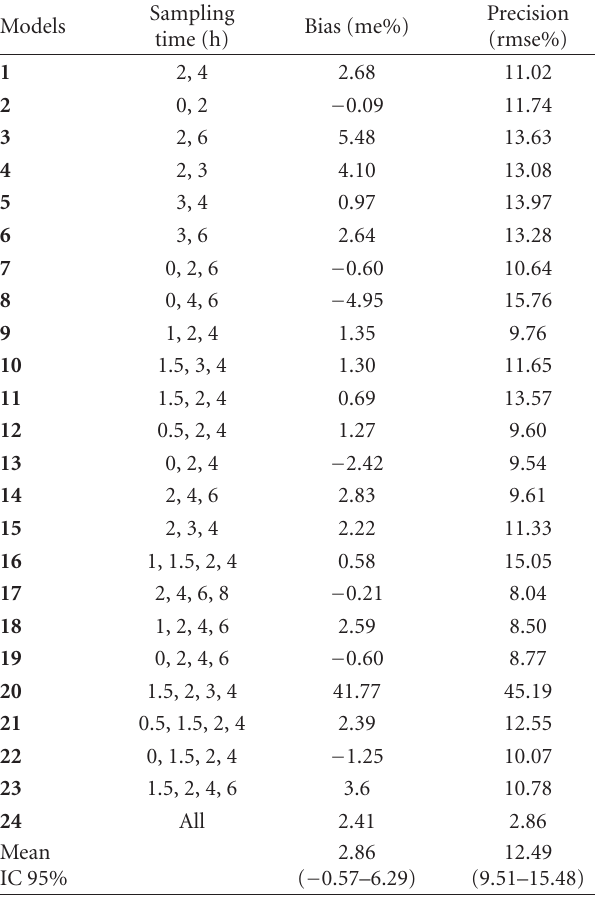
Table 5: Prediction bias and precision of models for estimating the cyclosporine (CsA) AUC 0 − 12h ( n =